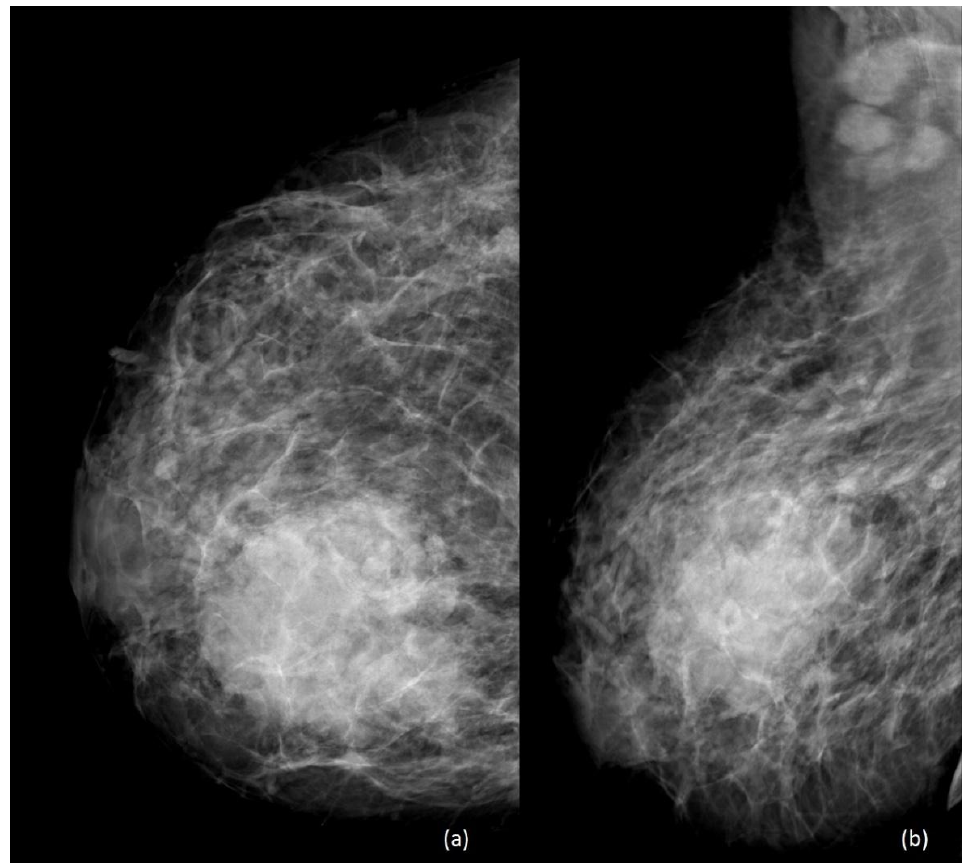
Figure 3. A 36-year-old breastfeeding patient, 6th month postpartum. ( a ) Craniocaudal view ( b ) and mediolateral oblique view of the right breast, characterized by increased density due to breastfeed- ing.